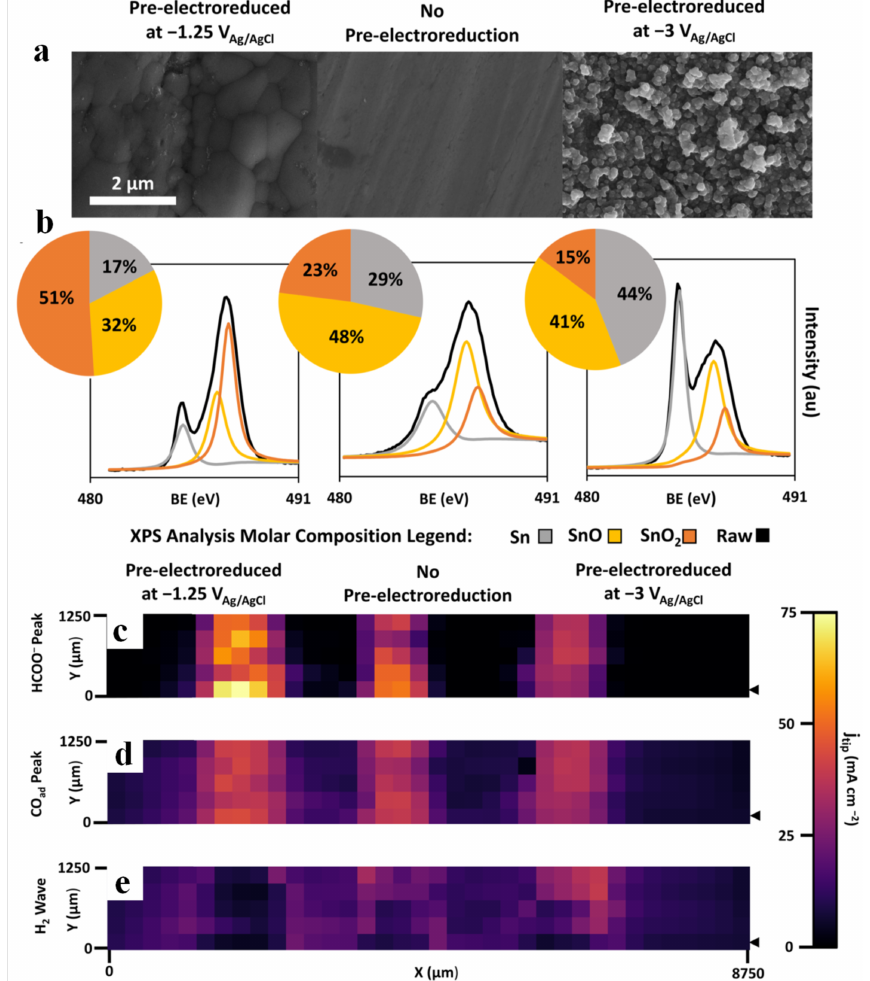
Figure 7. Sn/SnO x catalyst array characterization. SEM imaging ( a ), XPS spectra and deconvolution at the Sn 3d 5/2 orbital with surface molar compositions calculated based on peak surface areas ( b ). Pt UME tip current densities obtained from the backward CV-SECM scan and attributed to the three products of CO 2 RR: HCOO − ( c ), CO ad ( d ), H 2 ( e ). Pixel size: 250 × 250 µ m. The black arrow indicates the starting position of the tip. Adapted with permission from ref. [14]. Copyright 2009 Springer